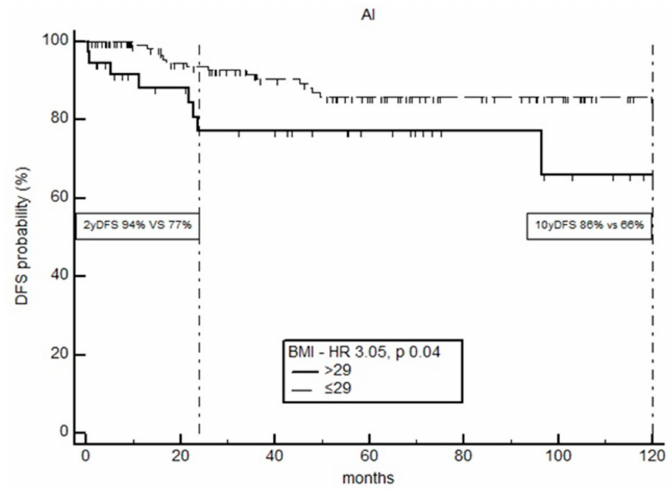
Figure 4. Two- and ten-year disease-free survival of BC patients stratified according to BMI cut- off value.